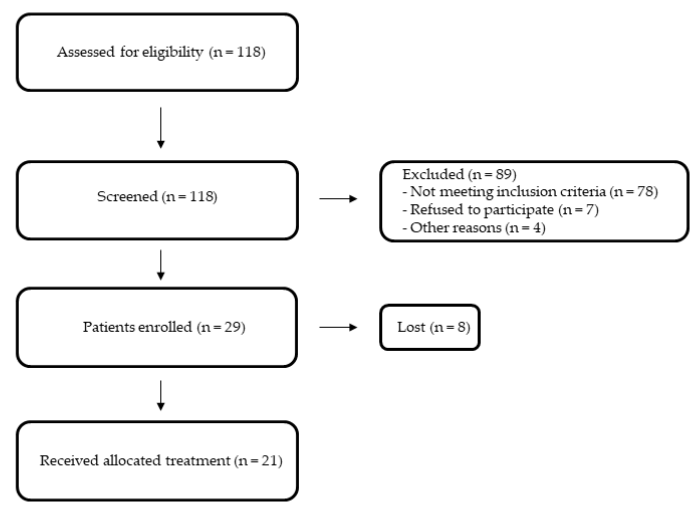
Figure 1. Study flow